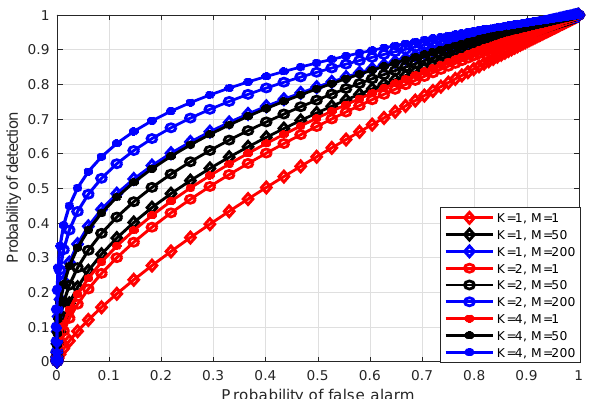
Figure 2. P D vs. P FA when sensor antenna number K = 1, 2, 4.